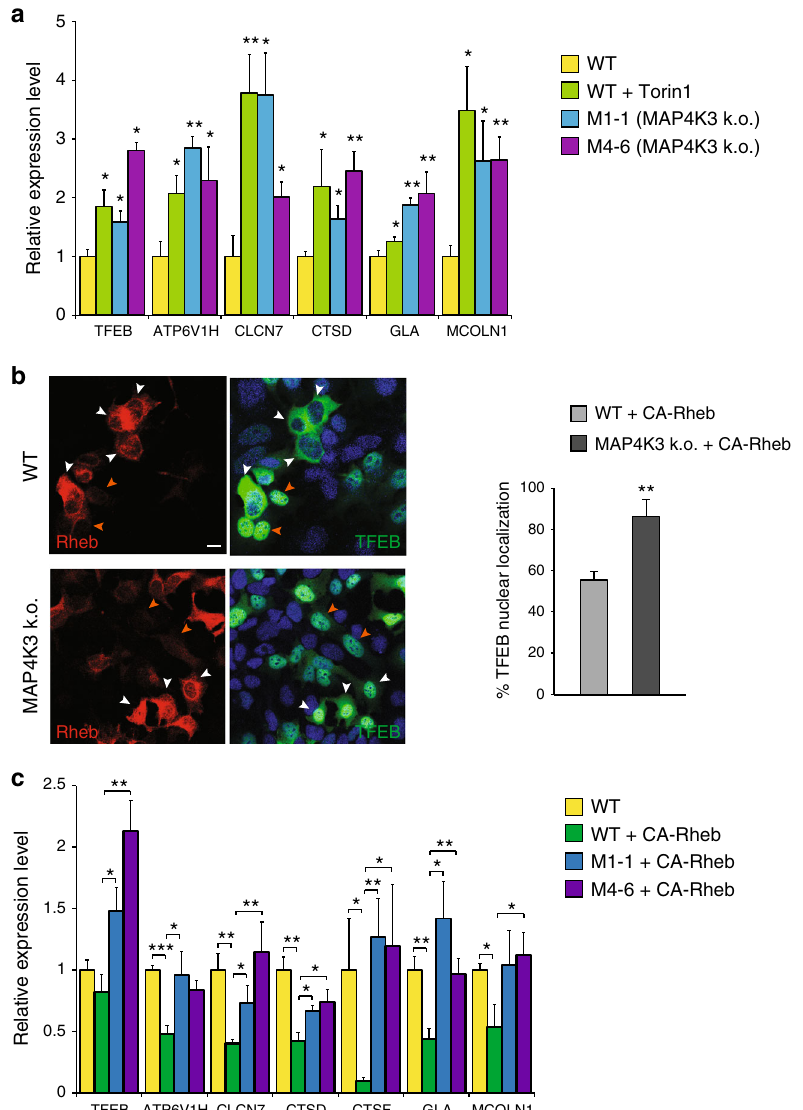
Fig. 3 MAP4K3 regulation of TFEB is upstream of mTORC1. a Knockout of MAP4K3 promotes TFEB-mediated transactivation of its target genes. WT HEK293A cells, untreated, or treated with Torin1, and two different MAP4K3 k.o. cell lines were cultured in CM. Quantitative RT-PCR of isolated RNAs for these cell lines was performed for six TFEB target genes. One-way ANOVA with post-hoc Tukey ’ s test; * P < 0.05, ** P < 0.01. b Activation of mTORC1 does not alter TFEB localization in MAP4K3 k.o. cells. WT HEK293A cells and MAP4K3 k.o. cells were transfected with an expression construct for constitutively active Rheb, epitope-tagged with myc, and starved of amino acids for 120 min. Although untransfected WT HEK293A cells exhibit TFEB nuclear localization (orange arrows), many WT HEK293A cells expressing constitutively active Rheb display TFEB cytosolic localization (white arrows). Although untransfected MAP4K3 k.o. cells also exhibit TFEB nuclear localization (orange arrows) as expected, most MAP4K3 k.o. cells expressing constitutively active Rheb show that TFEB still localizes to the nucleus (white arrows). Scale bar = 10 μ m. Quanti fi cation of cells with predominantly TFEB nuclear localization for this experiment is shown in the adjacent graph. n > 50 cells per condition. ** P < 0.01; two-tailed t -test. c Activation of mTORC1 does not prevent TFEB-mediated target gene activation in MAP4K3 k.o. cells. WT HEK293A cells, mock transfected, or transfected with constitutively active Rheb, and two different MAP4K3 k.o. cell lines, each transfected with constitutively active Rheb, were cultured in CM. Quantitative RT-PCR of isolated RNAs for these cell lines was performed for seven TFEB target genes. One-way ANOVA with post-hoc Tukey ’ s test; * P < 0.05, ** P < 0.01. All experiments were performed in triplicate. Error bars =